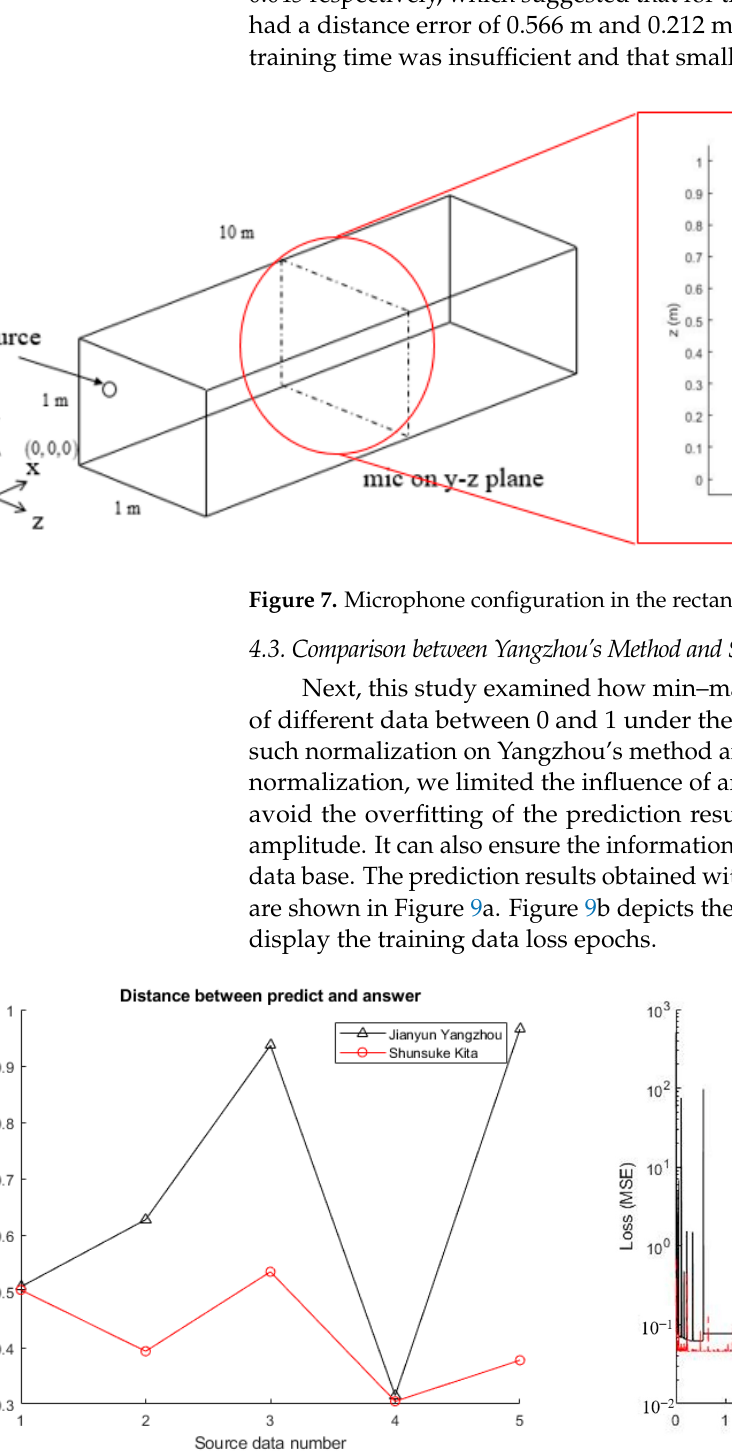
Figure 7. Microphone configuration in the rectangular cuboid model.